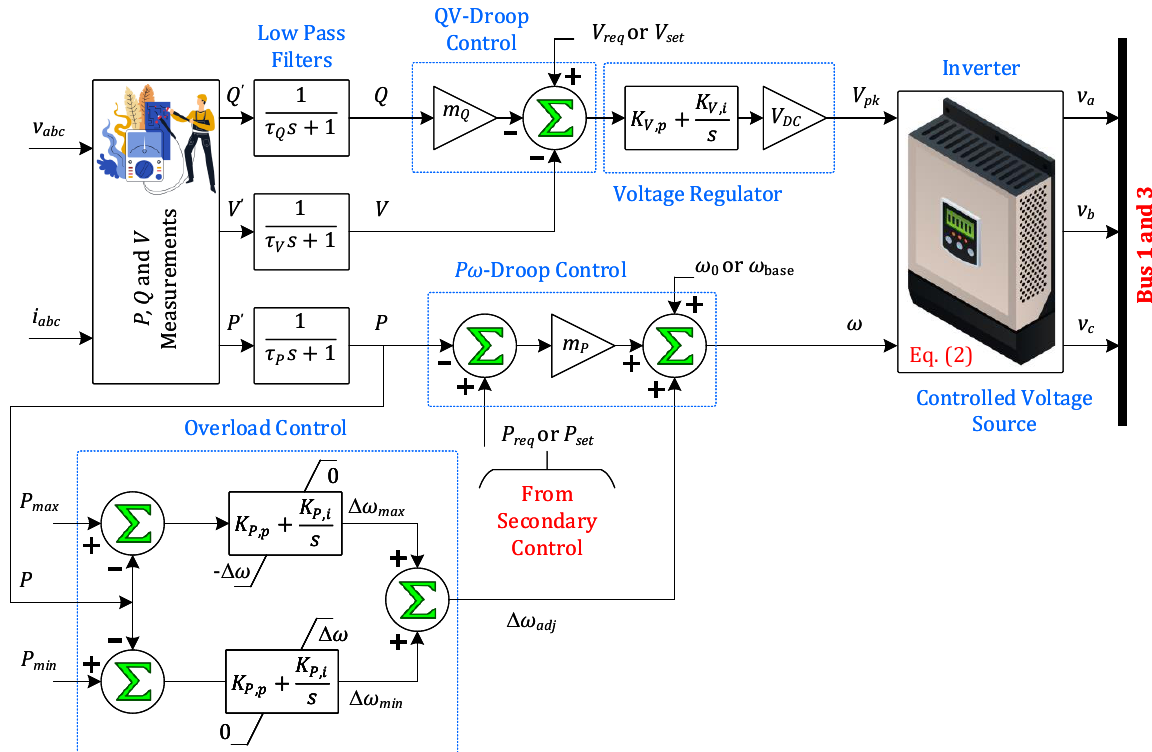
Figure 3. Primary control strategy for inverter-interfaced DGUs (i.e., ESS and